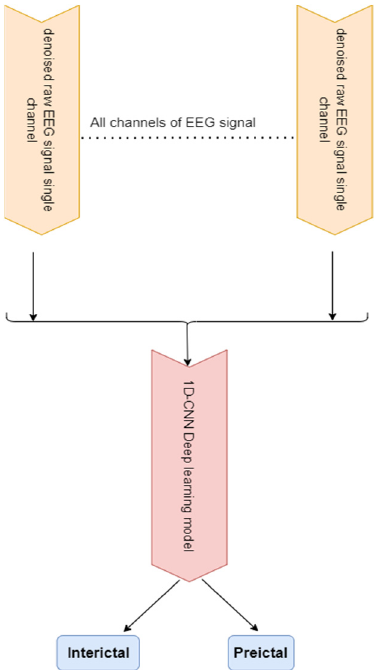
Figure 6. Proposed deep learning method.